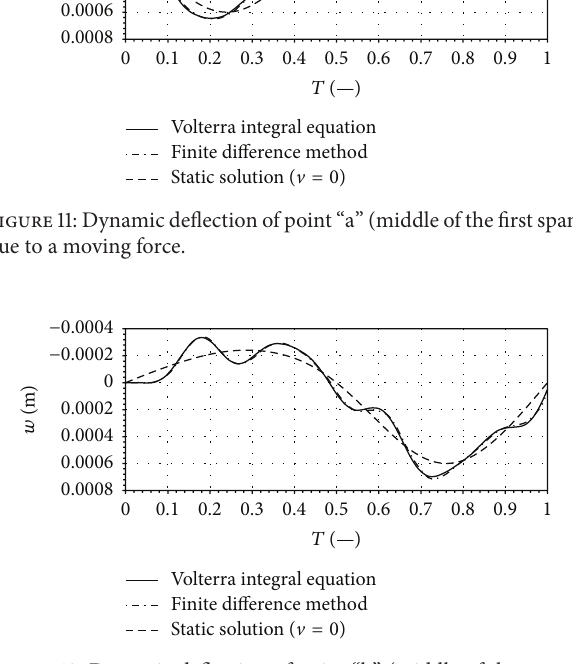
Figure 12: Dynamic deflection of point “b” (middle of the second span) due to a moving force.